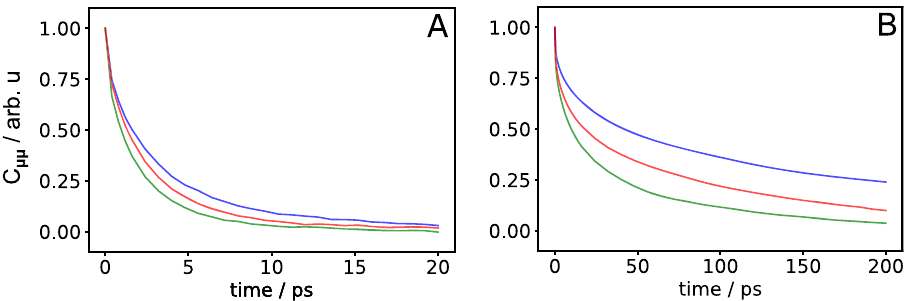
Fig. 4 | Dipole vector autocorrelationfunction for watermolecules nearthe Pt (111) electrode. A Double layer waters near the outer Helmholtz layer within 4<z<5 Å. B Adsorbed waters where z<3 Å. Surface water is attracted to the Pt surface, and the latticespacing ofPt(111)is suitablefor water to form a networkof